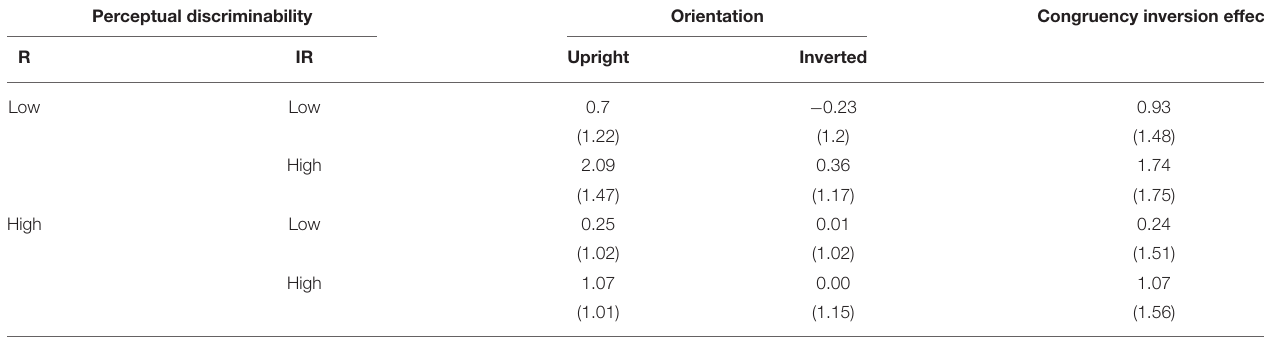
TABLE 2 | The mean congruency inversion effect (d’) for each condition in Experiment 1 ( N = 29) (standard deviations are shown in